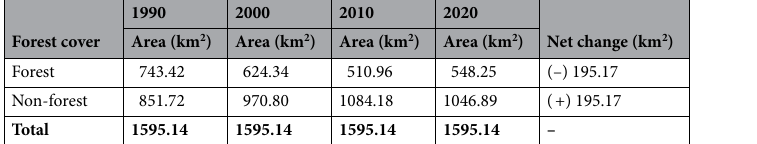
Table 2. Area under forest/non-forest and net change from 1990 to